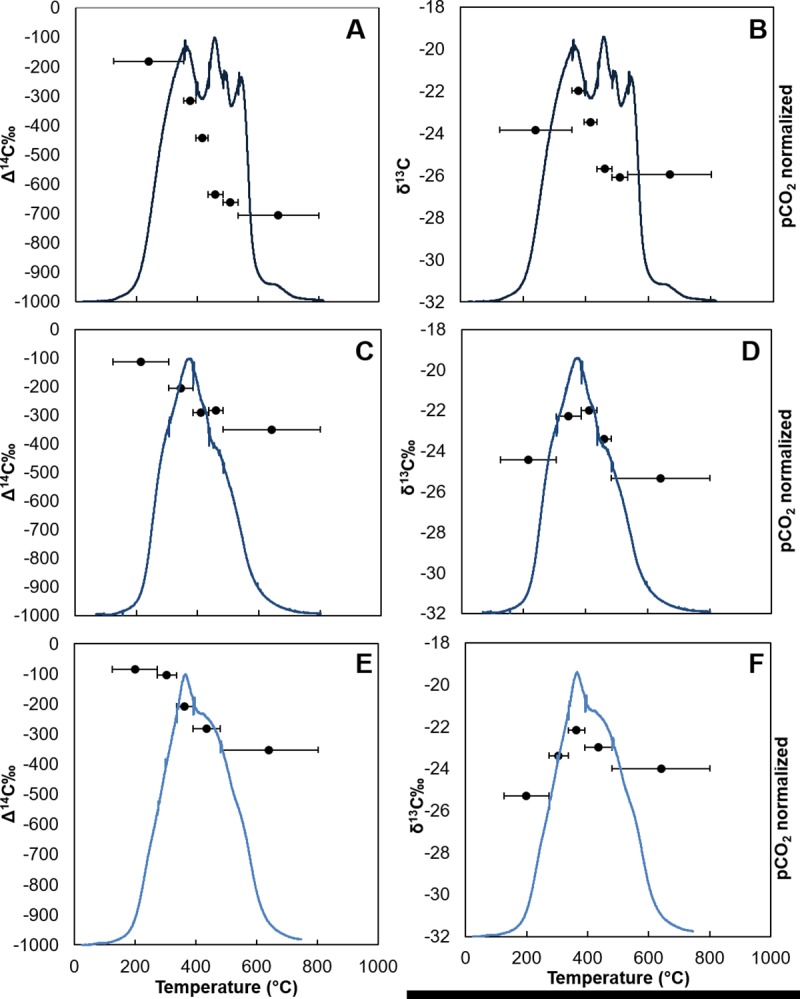
CO2 thermograph and isotopic composition of evolved
CO2 for site GIP07.Temperature interval of CO2 fractions indicated by horizontal
bars. A) GIP07 2010 Δ14C, B) GIP07 2010 δ13C, C)
GIP07 2011 Δ14C, D) GIP07 2011 δ13C, E) GIP07 2014
Δ14C, F) GIP07 2014 δ13C.